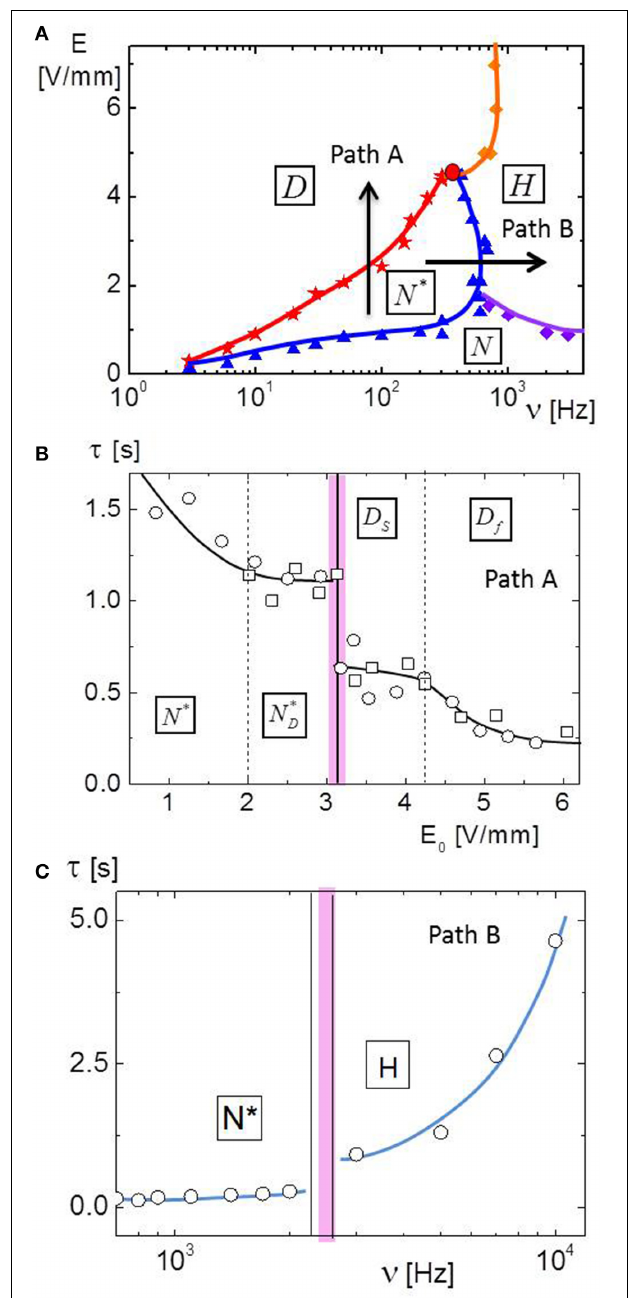
FIGURE 8 | (A) A simplified electric phase/state diagram, which defines the paths A and B. (B,C) The relaxation time of dynamic light scattering correlations functions along path A and path B, respectively. Colored lines are different phase transition lines. Colored symbols and lines indicate the phase transition